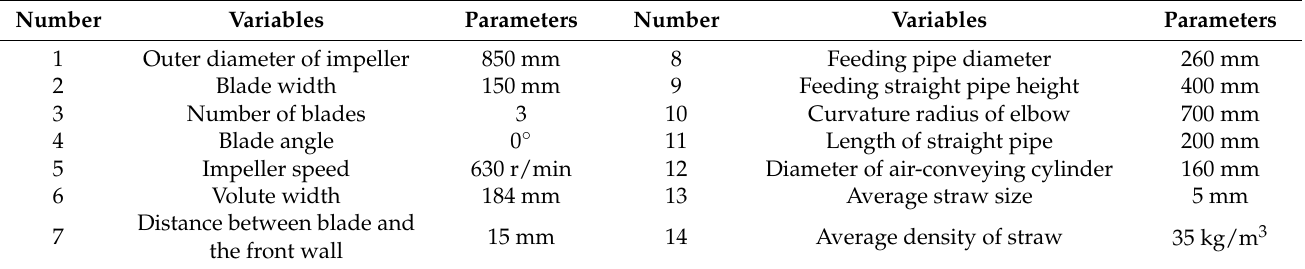
Table 1. The main parameters of the calculation area of the scrap air-conveying integrated